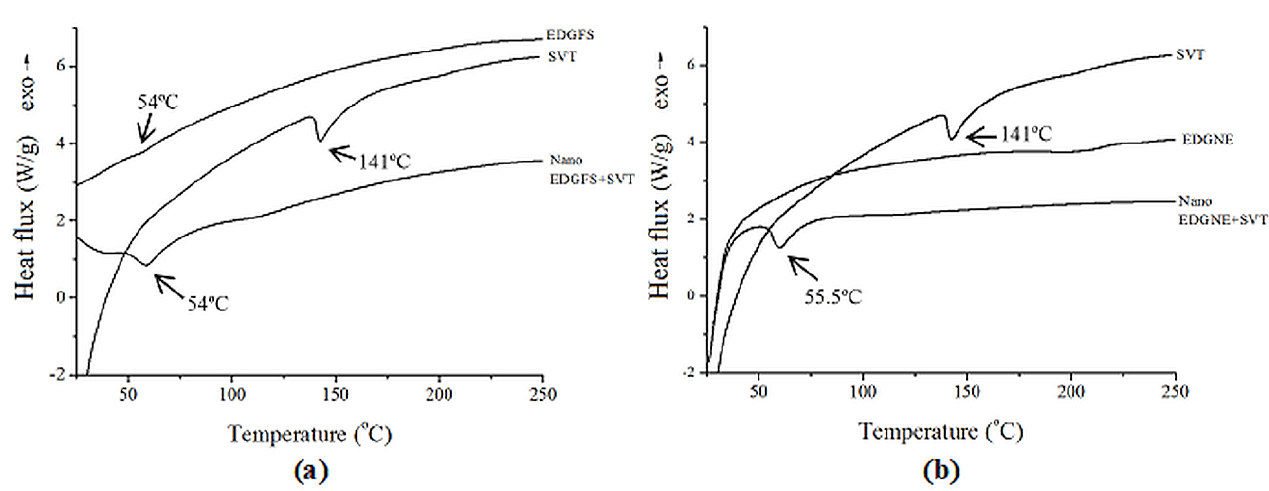
FIGURE 5 - DSC curves for simvastatin (SVT), Eudragit ® FS30D (EDGFS), simvastatin-loaded Eudragit ® FS30D nanoparticles (Nano EDGFS+SVT) (a), Eudragit ® NE30D (EDGNE) and simvastatin-loaded Eudragit ® NE30D nanoparticles (Nano EDGNE+SVT) (b), obtained under a dynamic atmosphere of N , flow rate of 50 mL min -1 and heating rate of 10 ºC min -1 . 2